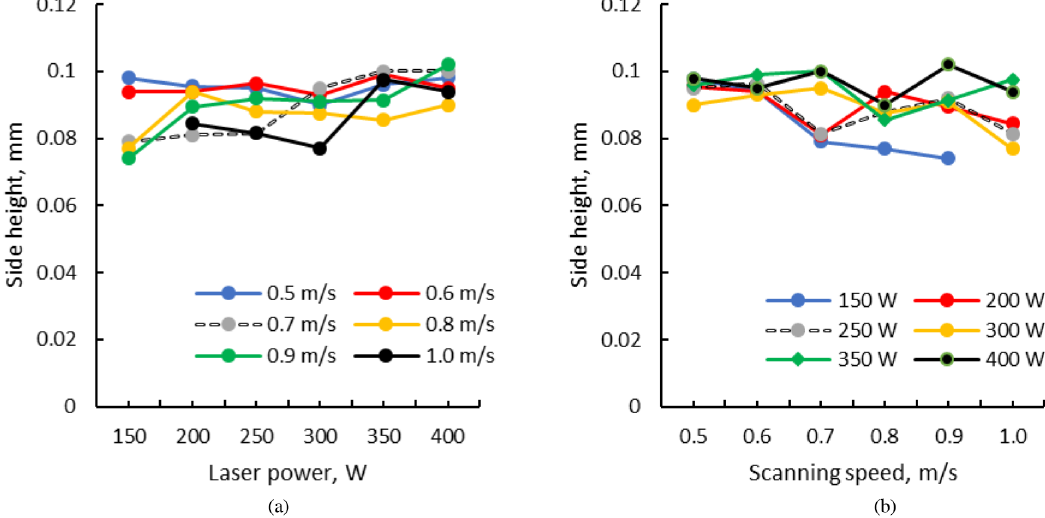
Fig. 8. Side ridge height as a function of laser power (a) and scanning speed